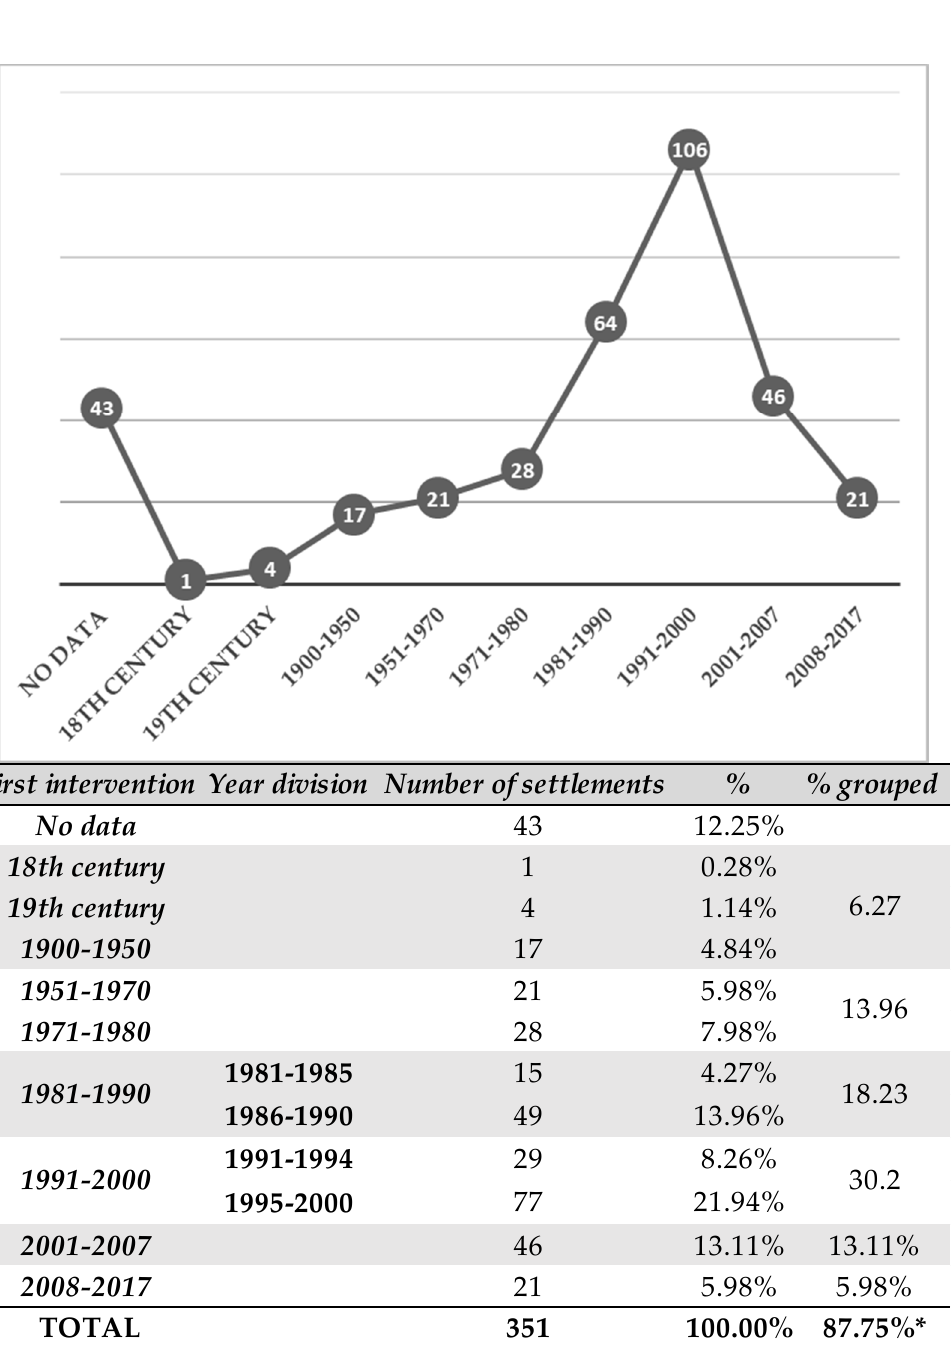
Figure 2. First interventions carried out in the rural sites of the corpus (* subtracting sites with no data). Own elaboration.